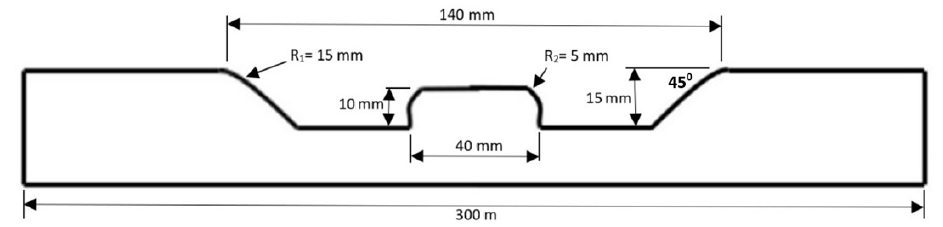
Figure 7. Drawing of the die used in experimentation. Table 3. Coil parameters used in the experimentation.